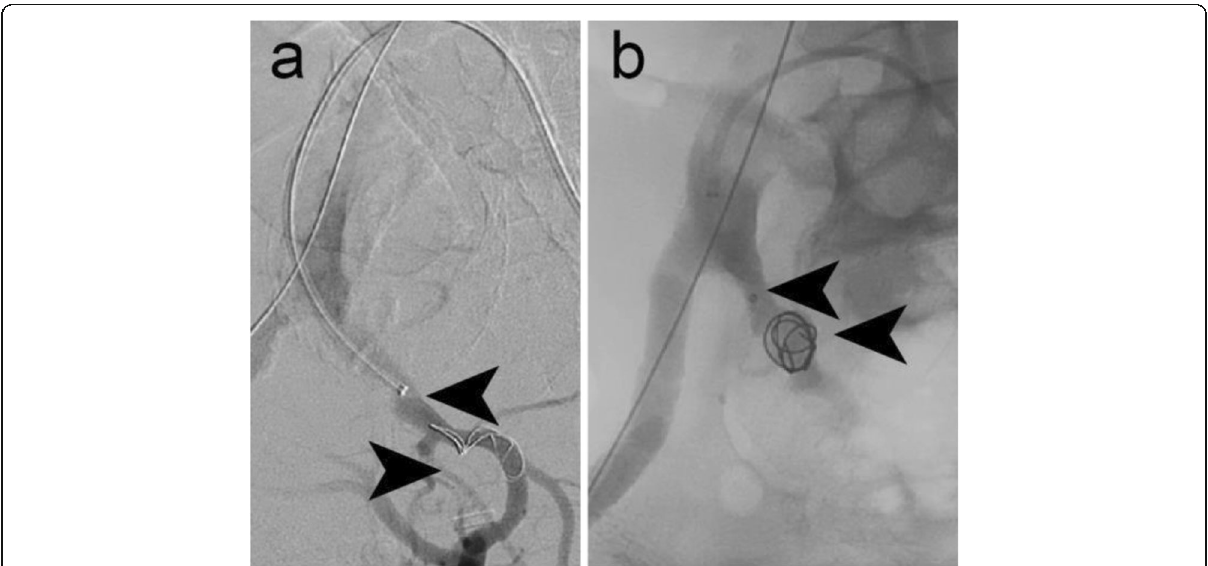
Fig. 3 Intraprocedural DSA imaging of a case 2 and b case 3 (both embolisation of right IIAs) using 12 mm diameter shape memory polymer plugs (one device in each case) in 8 mm diameter right IIAs. Arrows indicate the device anchor coils and proximal markers, where the anchor coil is distal to the marker. Shape memory polymer is radiolucent but is between the anchor coil and proximal